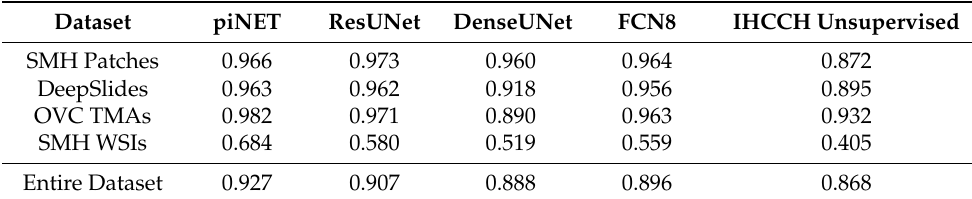
Table 9. Pearson related coefficient (R) across four datasets.